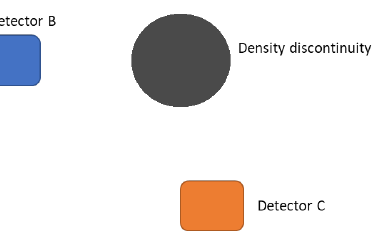
Figure 4. Schematic of the simulated scenario. Detectors (not in scale) placed in the positions A, B and